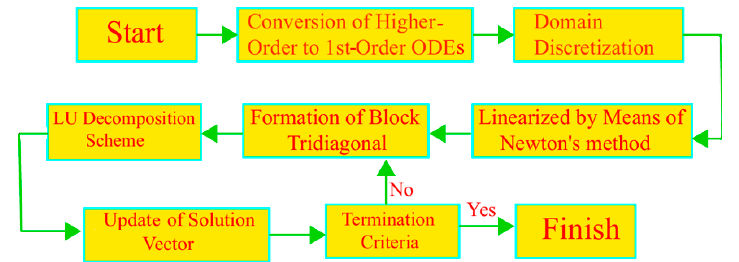
Figure 2. Flow chart illustrating Keller-box method.